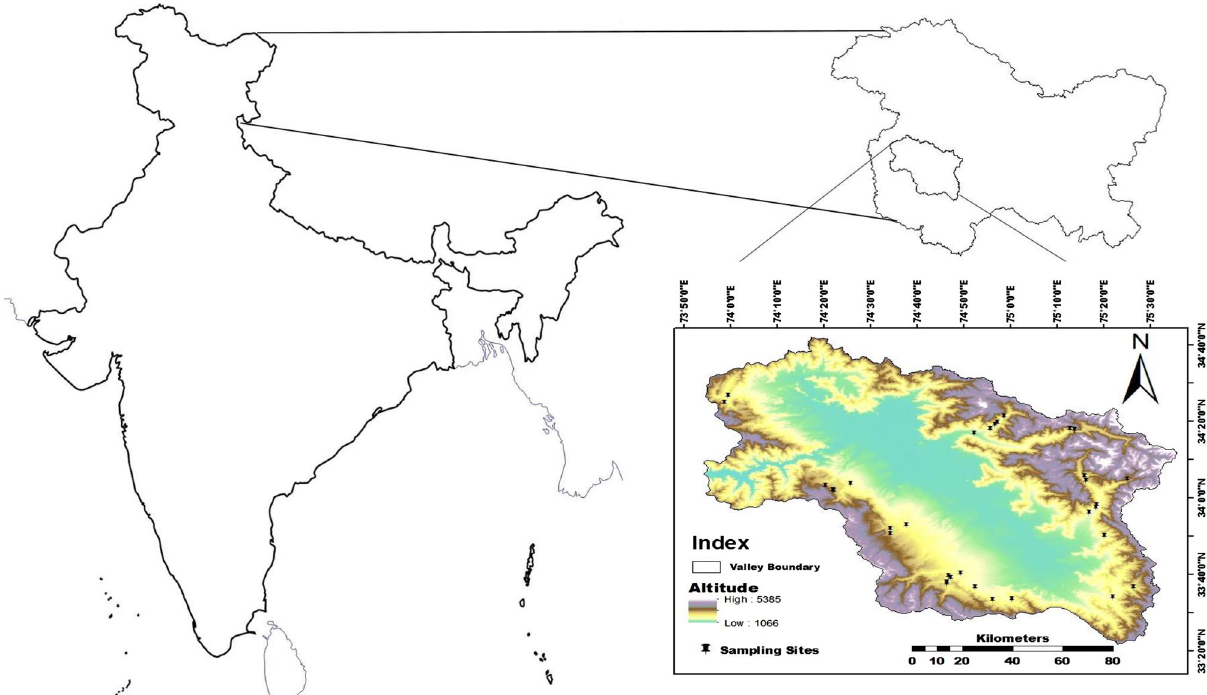
Figure 4. Study area showing sampling sites marked as black dots on the map inset (ArcGIS 10.2; http:// resou rces. arcgis. com/ en/ help/ main/ 10.2/ index.